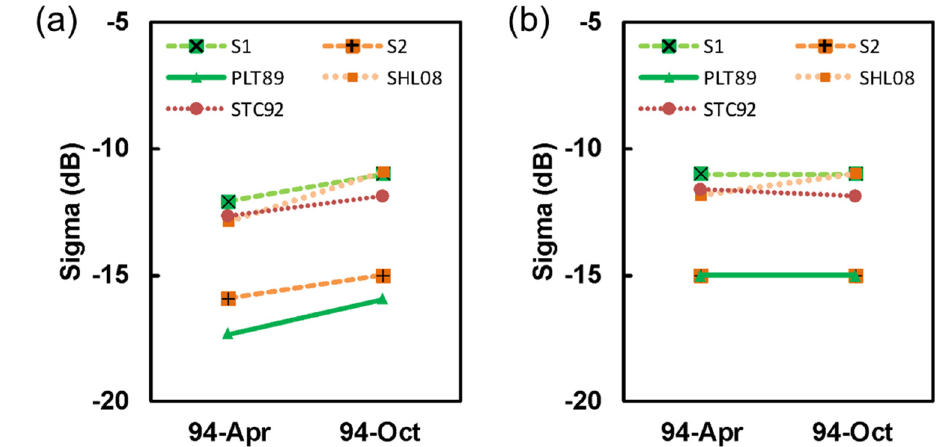
Figure 8. Changes in SAR backscatter (HV) from SIR-C/XSAR 1994 for selected plots; ( a ) before normalization, and ( b ) after normalization.